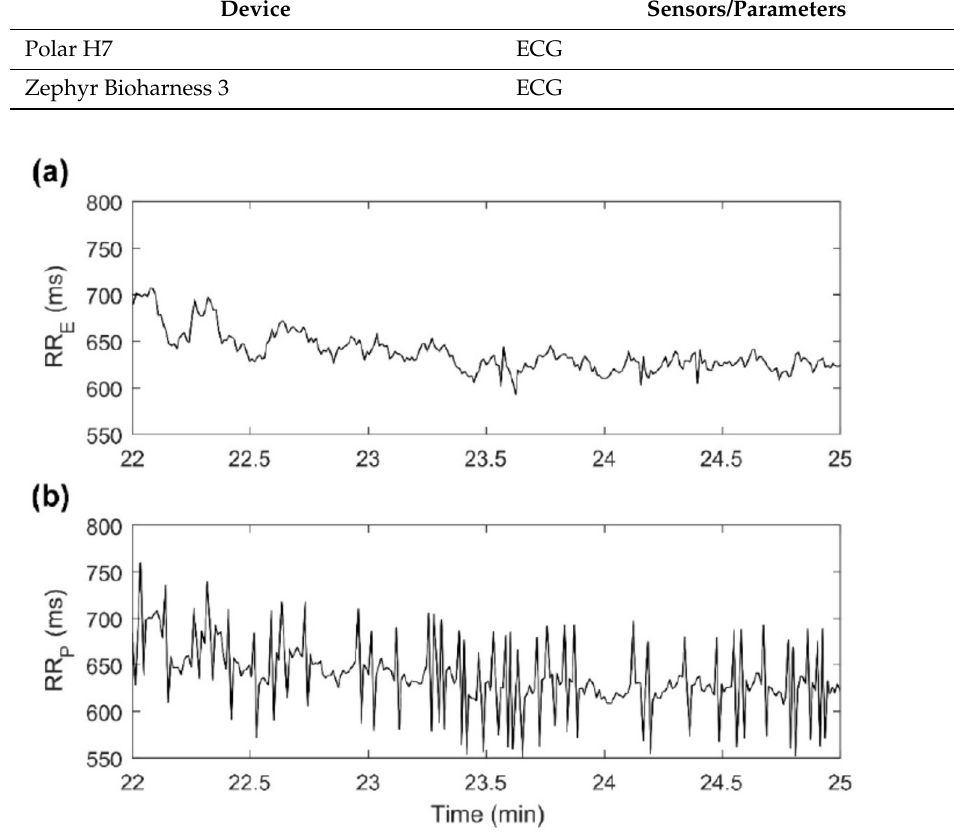
Figure 9. Example of RR intervals recorded by ECG and a PPG-based device (Polar H7) during recovery after exercise in one subject. ( a ) RRE = RR interval series recorded by ECG; ( b ) RRP = RR intervals series recorded by the PolarH7. Compared to the ECG, the PPG method overestimates the HRV. Reprinted from [55]. No changes were made to the image, which has been published under CC BY 4.0 license (https://creativecommons.org/licenses/by/4.0/legalcode).